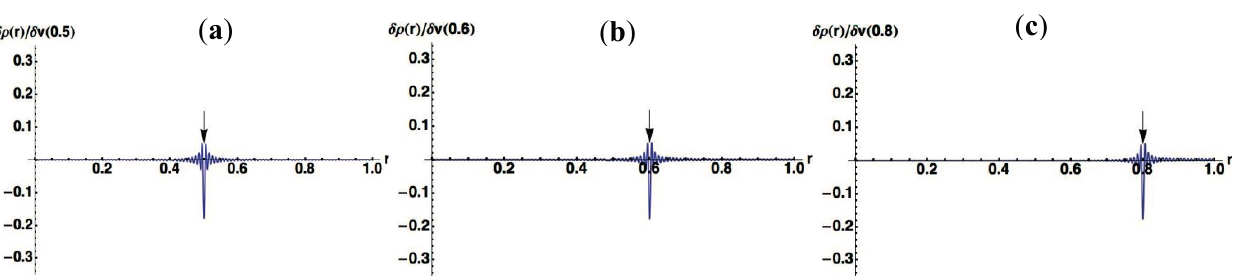
Figure 3. Plots of dr(r)/dv(r ′ ) where virtual perturbations are applied to specific points (r ′ ) indicated by arrows for the Nocc = 50 case. ( a ) r ′ = 0.5; ( b ) r ′ = 0.6; ( c ) r ′ =